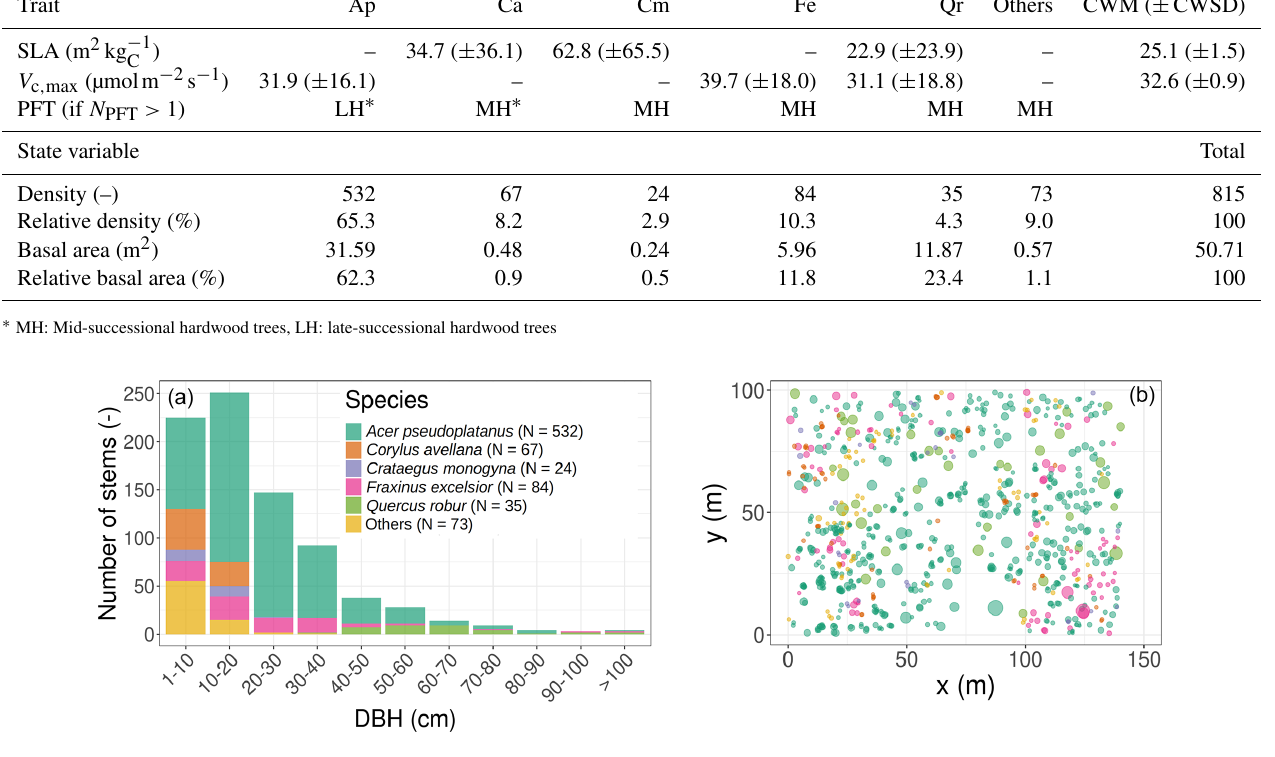
Figure 1. Initial conditions in terms of tree size distribution and species composition (a) , horizontal position, basal area (the size of the circles in panel (b) is proportional to the individual basal area), and species composition (b) . The colour legend for species applies to both panels and is kept the same for Fig. 2 and Table 1. In the simulations, all trees were classified into single or multiple plant functional types according to the species PFT in Table